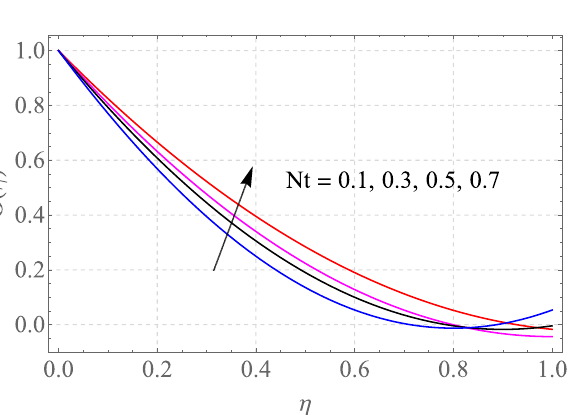
Figure 11. Alterations in �(η) as Nt raises. When M = S = 0.1, Pr = 6.2, Gc = 0.2, Ec = 1, Nb = 0.3, Sc = 0.3